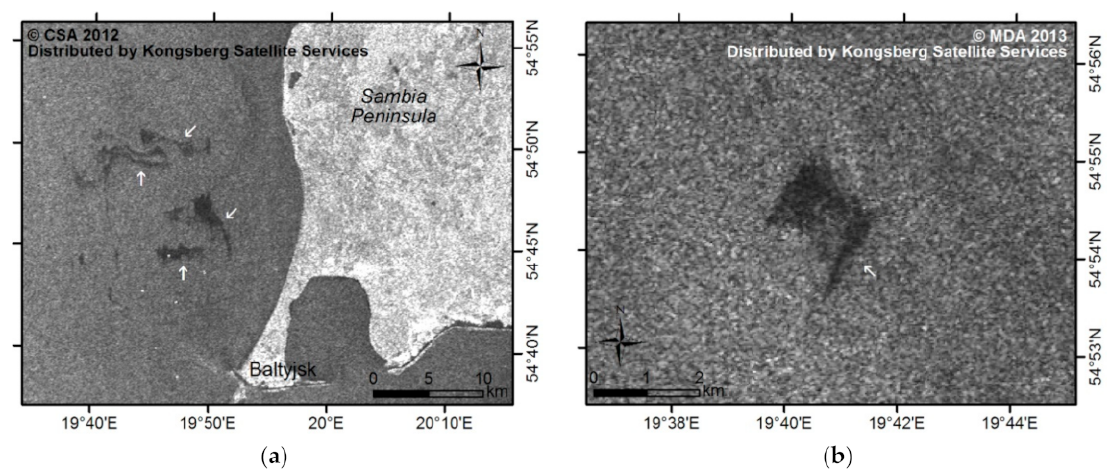
Figure 4. Examples of oil spills of other shapes. Oil spills are shown with white arrows. ( a ) Radarsat-1, 26.04.2012 (16:12 UTC) and ( b ) Radarsat-2, 20.06.2013 (16:15